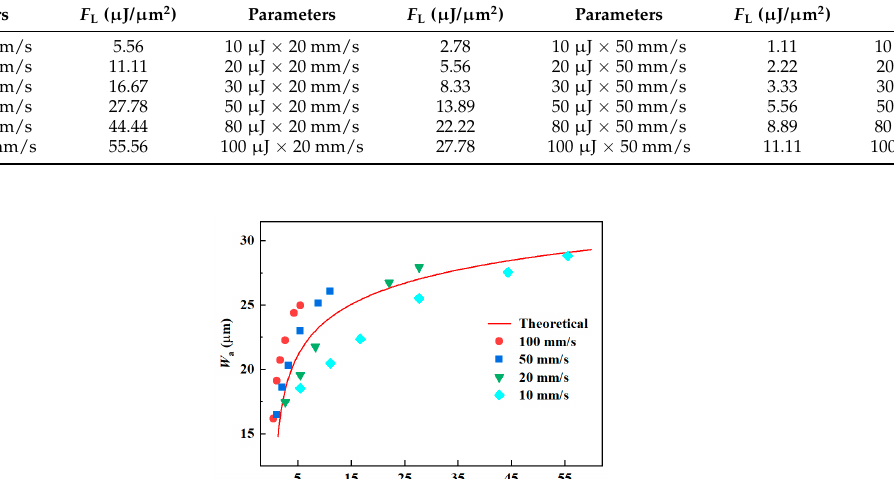
Figure 5. E ff ects of parameters on width. ( a ) The width varies with laser energy. ( b ) The width varies with scanning speed. Table 2 shows the experimental parameters and the corresponding F L values, which increased with the laser energy and decreased with the scan speed. The predicted results of W a are shown in Figure 6, with the experimental data distributed around the prediction curve. There were several data deviations from the curve on the upper side of the curve when v ( ≥ 50 mm/s) and E p ( ≥ 80 µJ) were high. When F L = 2.78 µJ/µm 2 , the theoretical value was 22.25 µm, the experimental value was 18.47 µm, and the prediction error was as high as 20.5%. At this point, the thermal e ff ect increased due to the enormous laser energy, making the ablation width slightly larger than the predicted value. The maximum devia- tion error below the curve was 14.7 when F L = 11.11 µJ/µm 2 . At slower scanning speeds, the material was removed mainly in photothermal heat, leaving the ablation products to Table 2. Experimental parameters and their corresponding F L . recondense at the edges of the microgrooves, so their widths were less than predicted. Table 2. Experimental parameters and their corresponding F L .